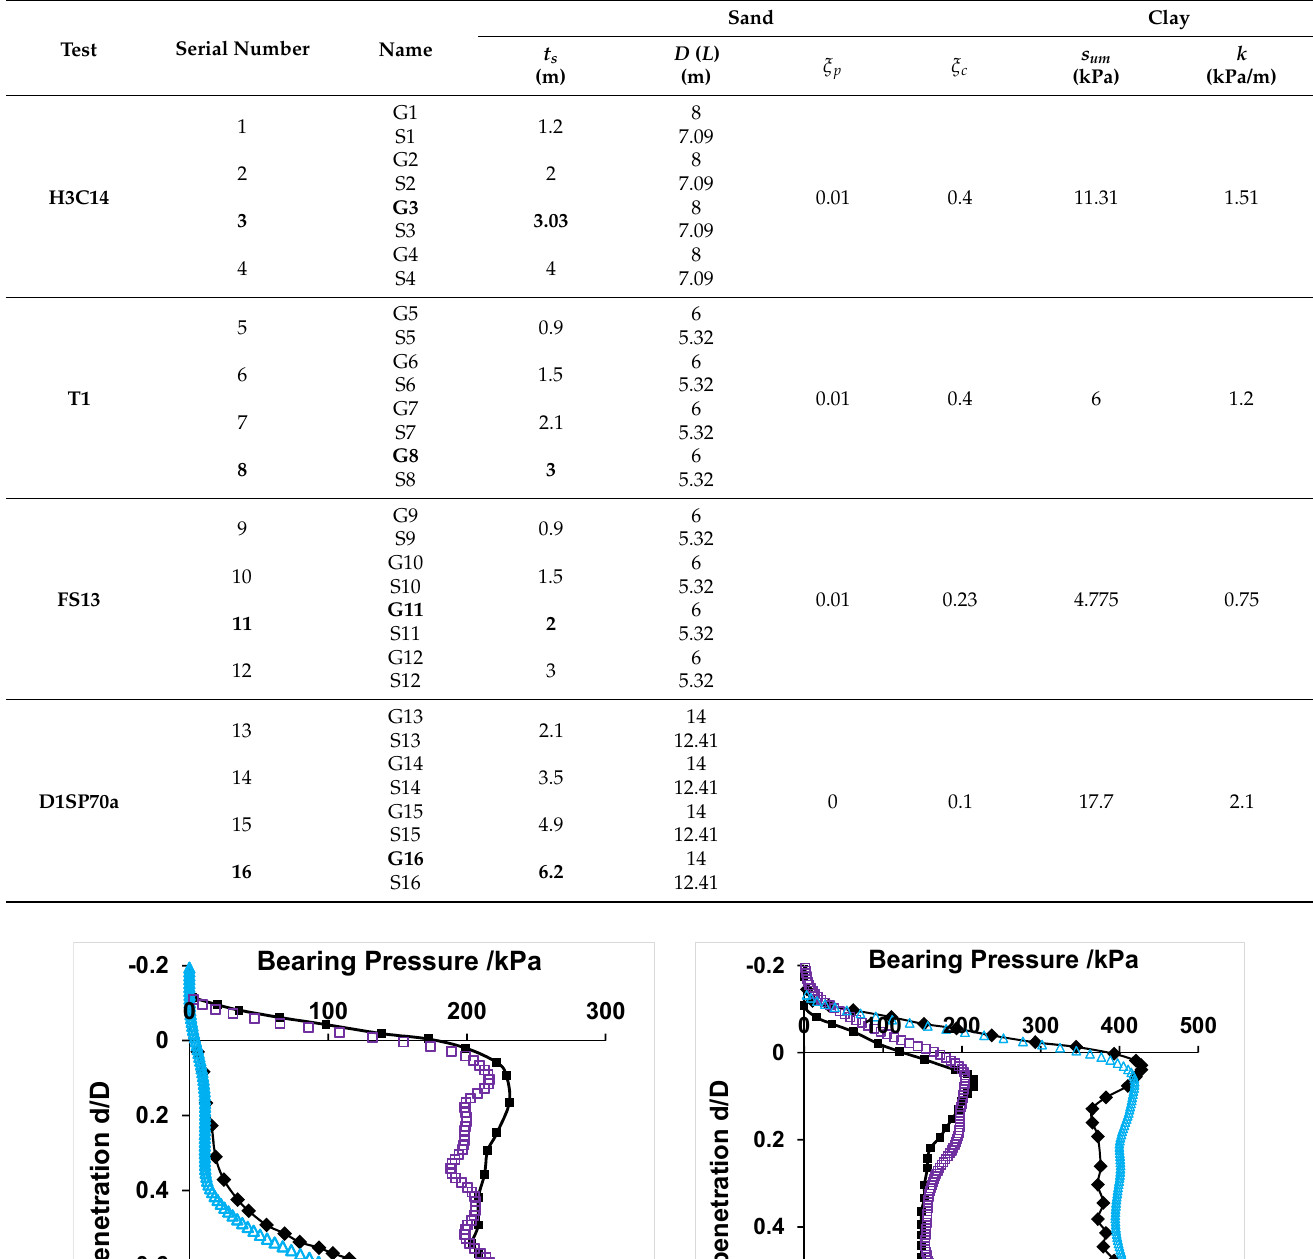
Table 2. Summary of LDFE analyses.